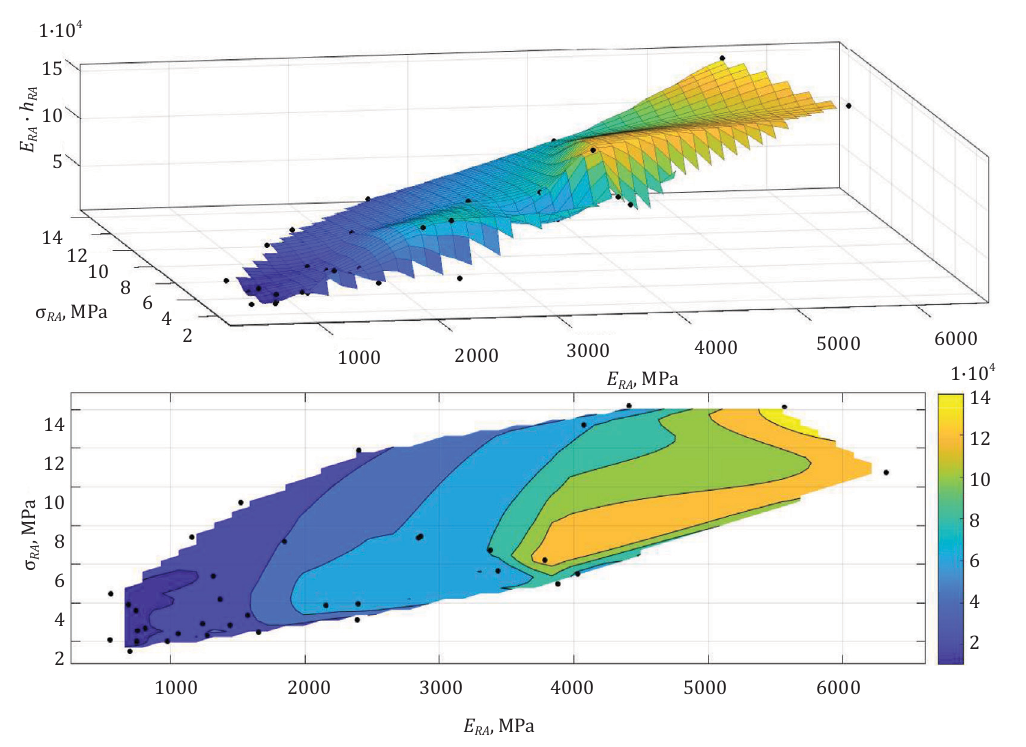
Figure 8. Data approximation using the ANN processed